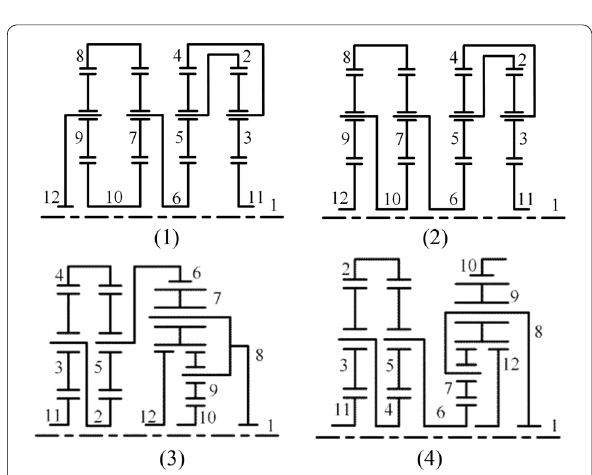
Figure 7 Function diagrams of four DBGs presented in Figure 6